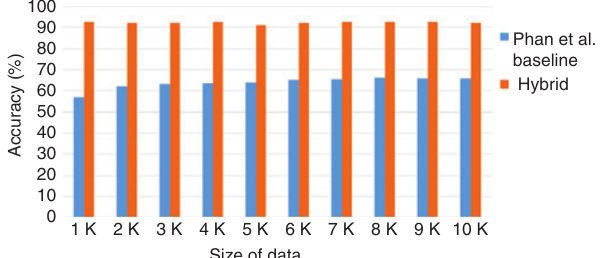
Figure 4: Accuracy of the CBER Approach in Comparison with the Baseline Approach as in Ref.